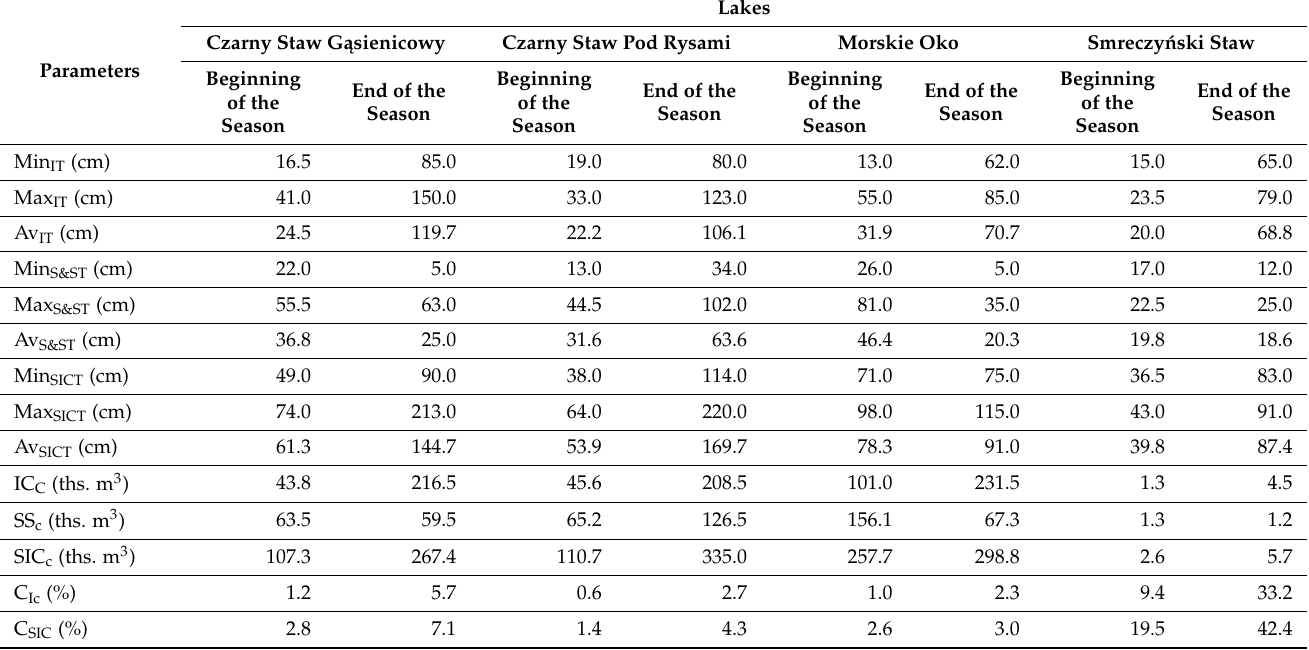
Table 3. Basic parameters of snow and ice cover in the studied lakes in the Tatra Mountains during the winter season